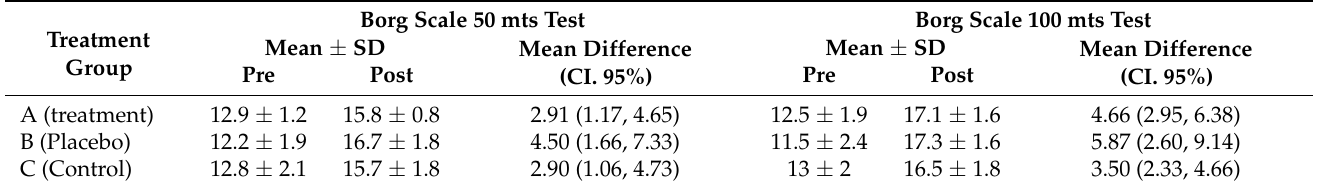
Table 3. Mean ± standard deviation of perceived effort per group and mean difference between pre and post-measures and their respective confidence interval.